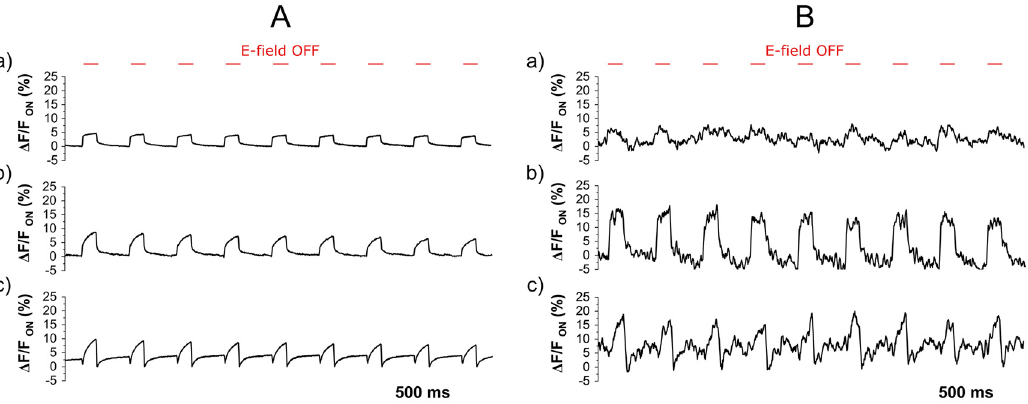
Figure 8: Optical response to a simplified 60 bpm cardiac action potential train with a resting potential corresponding to an electric fi eld of − 150kV/cmanda transientamplitudeof thesamemagnitudeof (a)thetype-IQD6-PSMA,(b)the quasi-type-II QD9-PSMAand(c) thequasi- type-II QR35-PSMA under 1P excitation (460 – 495 nm, panel A) and 2P excitation (900 nm,